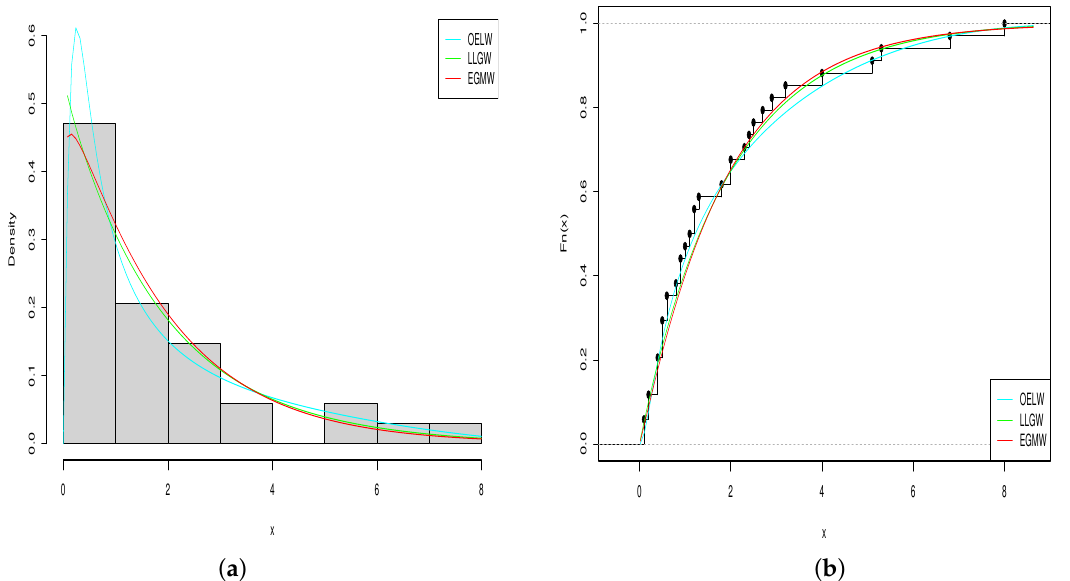
Figure 6 gives the graph of the estimated pdfs and cdfs of the considered distributions. Figure 7 gives the PP plot of the OELW distribution.